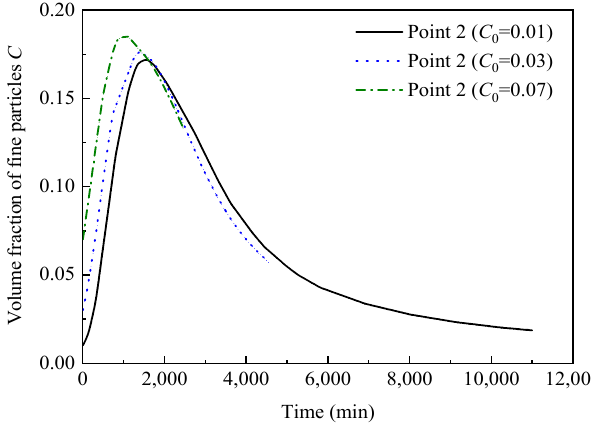
Figure 17. Evolution curves of the volume fractions of fine particles with different initial volume fraction of fine particles at point 2.